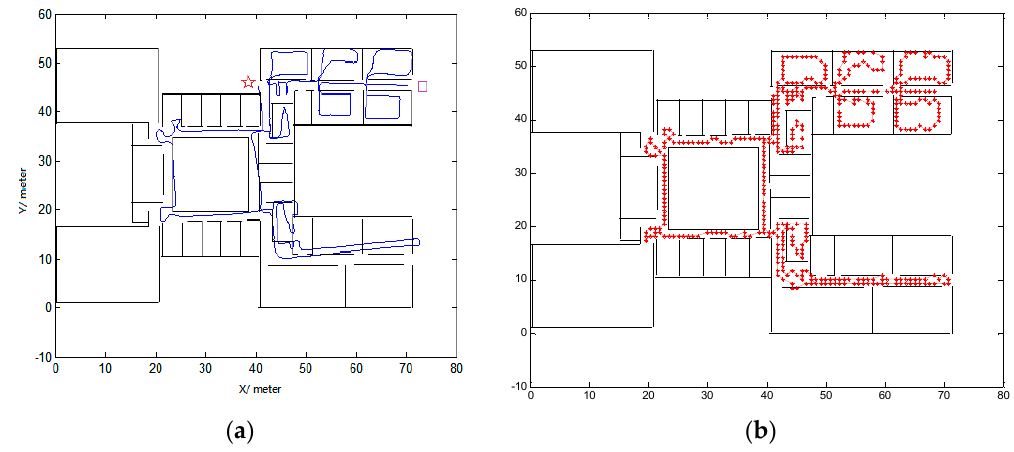
Figure 4. Comparison of trajectory with ( a ) being the raw trajectory and ( b ) being the trajectory using conditional random fields (CRFs).